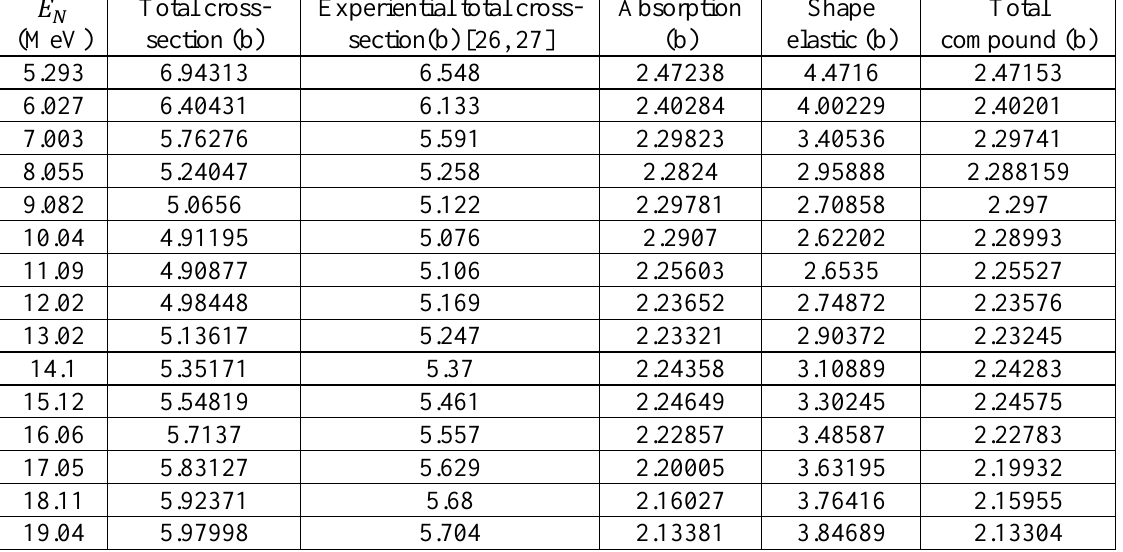
Fig. 1: The various potential well depths as a function of neutron energy incident for 197 Au nuclei. Table 1: The present calculated total integral cross-section using SOM in 197 Au (n, n) 197 Au reaction at different energies compared with available experimental